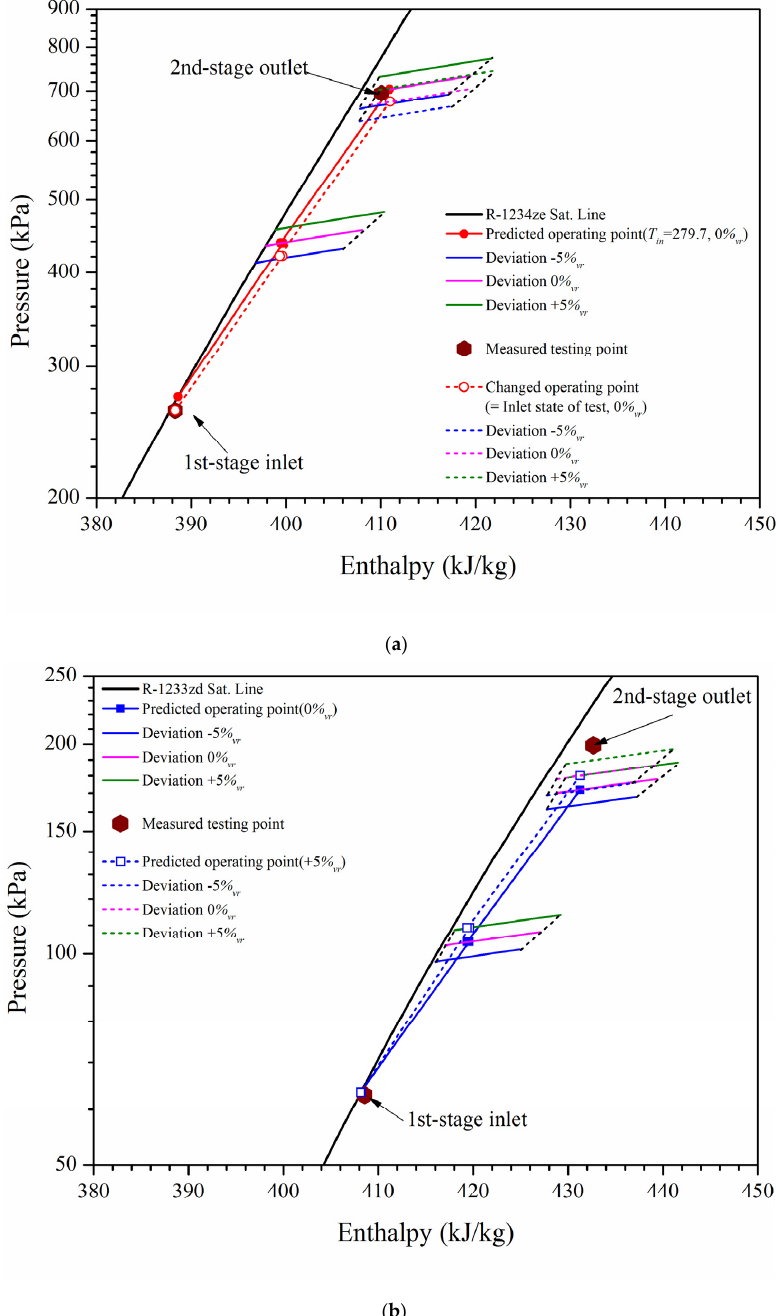
Figure 11. Comparison of predicted results and drop-in test results for ( a ) DR-34 and ( b ) DR-33. When the inlet temperature and pressure decrease, the predicted operating points at the first- and second-stage outlets decrease. Even when the inlet conditions are changed, the measured point is within the predicted operating range. Figure 11b compares the prediction results in the first and second stages of DR-33 with the measurements obtained via the drop-in test. The solid symbol and solid line indicate the predicted operating point at 0% vr . The pressure and temperature measured at the inlet of the first stage are very close to the theoretically predicted operating point with a difference of less than 0.5%. However, the pressure and temperature at the measured point of the second-stage outlet are higher by approximately 20 kPa (approximately 15%) and by approximately 2.4 K than those at the predicted operating point, respectively. This shows that the predicted operating point is low. The predicted operating point when operated at +5% vr in the first stage of DR-33 is indicated by an open symbol and a short-dashed line in Figure 11b. Even when the deviation of the specific volume ratio increases in the first stage, the predicted operating point at the second-stage outlet is low, and the predicted operating range is lower than the measured point. When we examine the operation characteristics of a general centrifugal compressor, if the operating flow rate decreases at a fixed rotational speed, the outlet pressure and temperature become higher than the design points. Because a decrease in the flow rate implies operation at an off-design point, the operation information for the off-design point of R-134a needs to be compared. On the other hand, from the systematic viewpoint of the chiller, because a low-pressure refrigerant was injected into a medium-pressure refrigerant system, the thermodynamic problem occurring in the condenser and evaporator can be considered. If the drop-in test of R-1234ze (E) and R-1233zd (E) can be performed on a turbo chiller for a low- pressure refrigerant, the thermodynamic influence of the heat exchanger can be analysed with complexity. Table 5 compares the total pressure ratio, polytropic efficiency, and gas power at the calculated operating point of the alternative refrigerant with the design conditions of R-134a. This shows that the operating pressure ratios of the first and second stages are similar even with a different refrigerant.